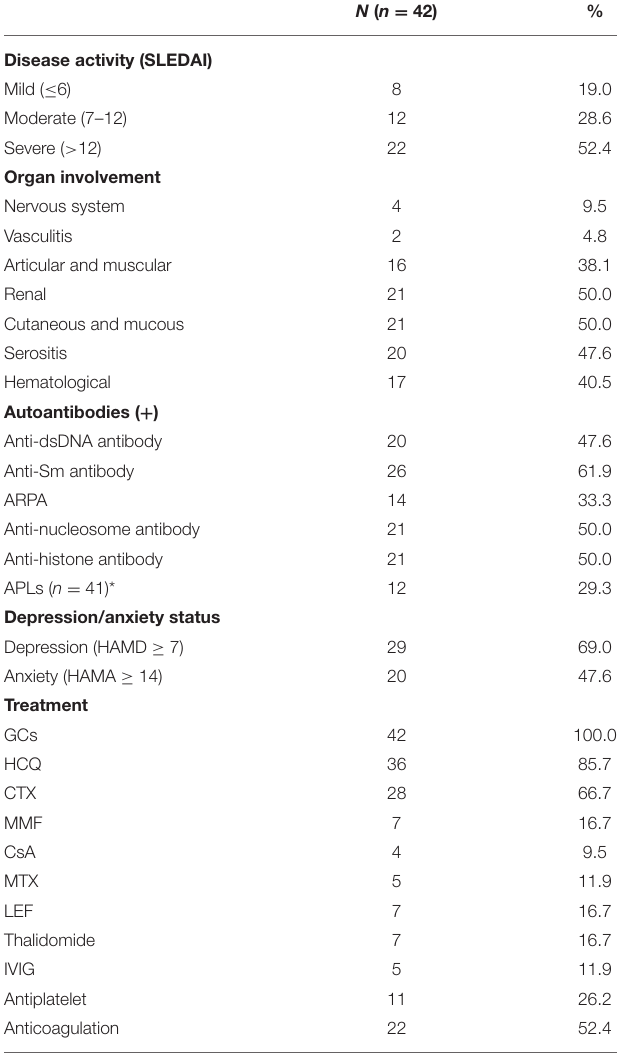
TABLE 2 | Clinical features and psychological assessment of SLE